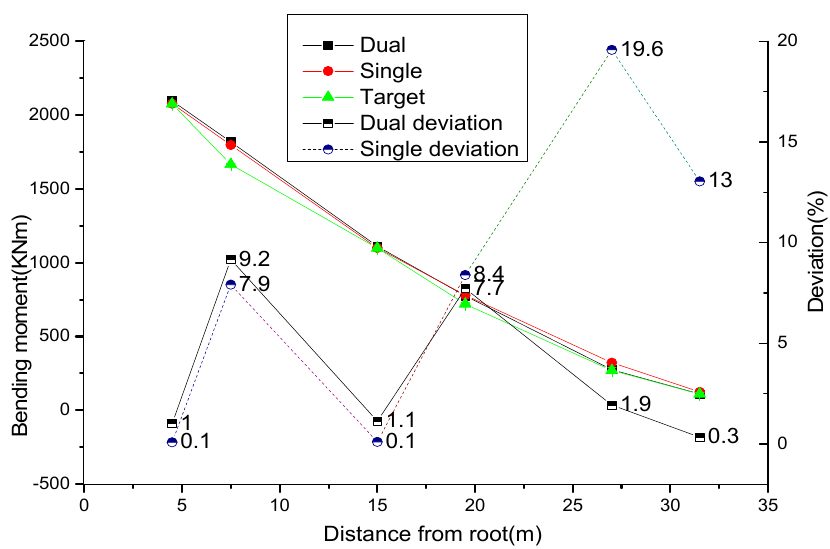
( b ) Figure 14. Two million cycle frequency distribution of the bending moment. ( a ) Frequency distribution of the bending moment in section 7.5 m; ( b ) Frequency distribution of the bending moment in section 19.5 m. Miner’s damage accumulation rule: